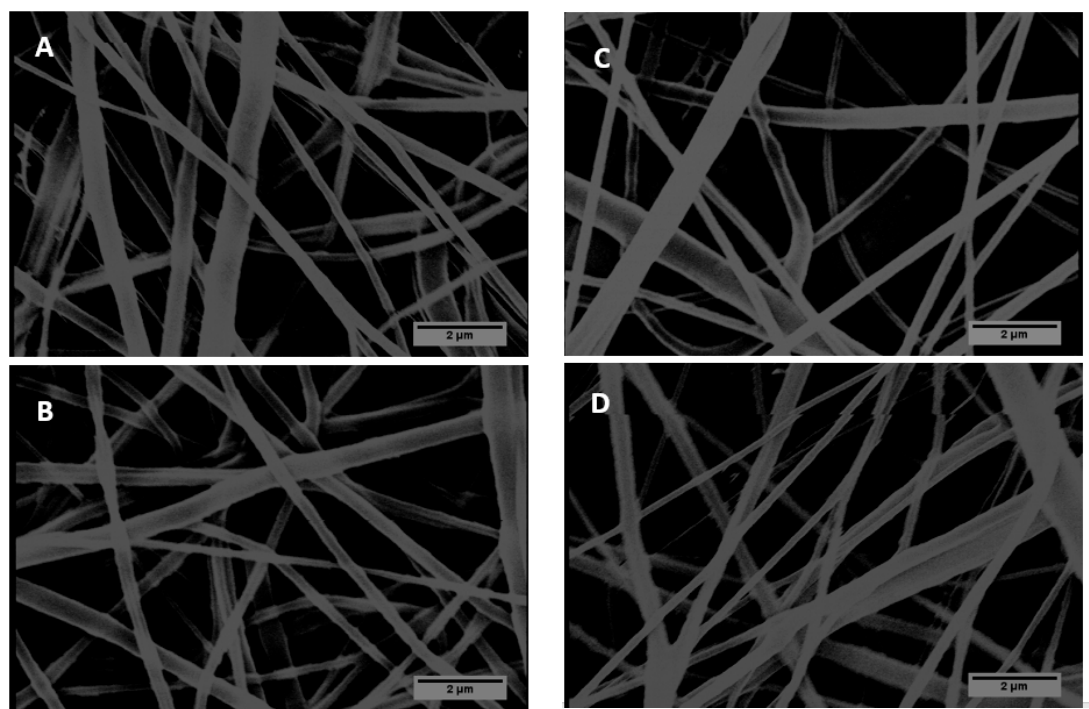
Figure 4. SEM images of the PCL/gelatin/188 (80:10:10 %w/v) composite nanofibers electrospun at ( A ) 18 kV, ( B ) 20 kV, ( C ) 22 kV, and ( D ) 24 kV voltages. The images were measured at a magnification of ×9000 to ×10,000.